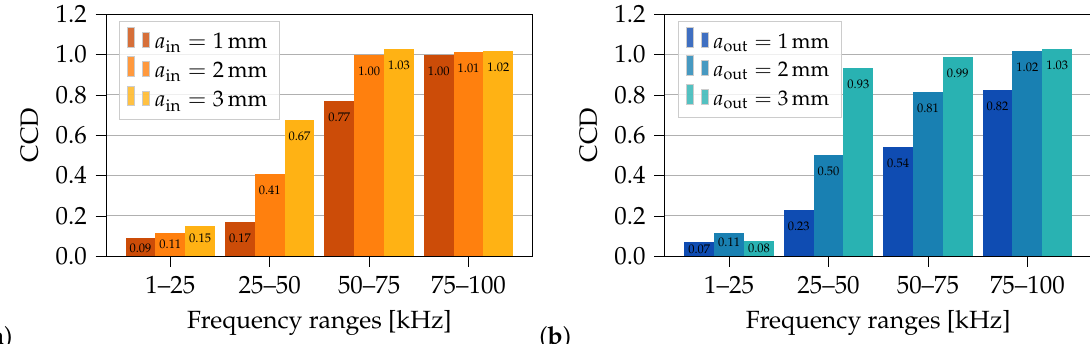
Figure 7. Comparison of damage metrics for growing cracks at locations ( a ) β in = 90° and ( b ) β out = 145°. All damage metrics are calculated with spectrum element S = G from FEM